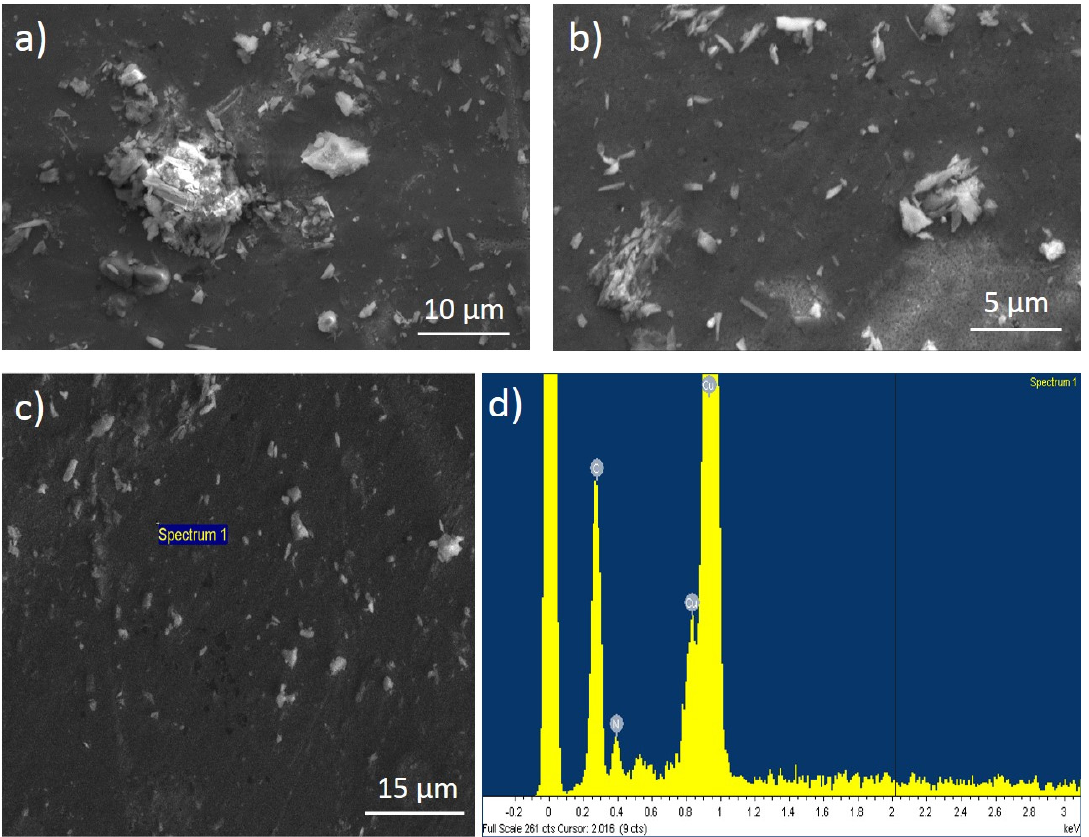
Figure 11. FE ‐ SEM micrographs in ( a – d ) the EDXS spectrum for the analysis of the spot designated in ( c ) of the 2PhI ‐ inhibited copper samples measured after 31 days of immersion in 3 wt. % NaCl solution.